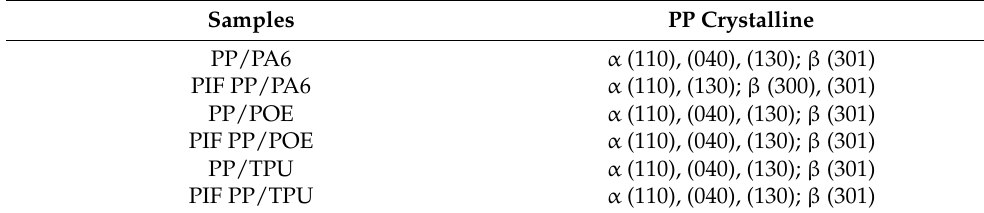
Figure 3. X-ray diffraction (XRD) spectra before and after PIF process, ( A ) PP/PA6, ( B ) PIF PP/PA6, ( C ) PP/POE, ( D ) PIF PP/POE, ( E ) PP/TPU, ( F ) PIF PP/ TPU . Table 1. Table of crystal face statistics before and after PIF process